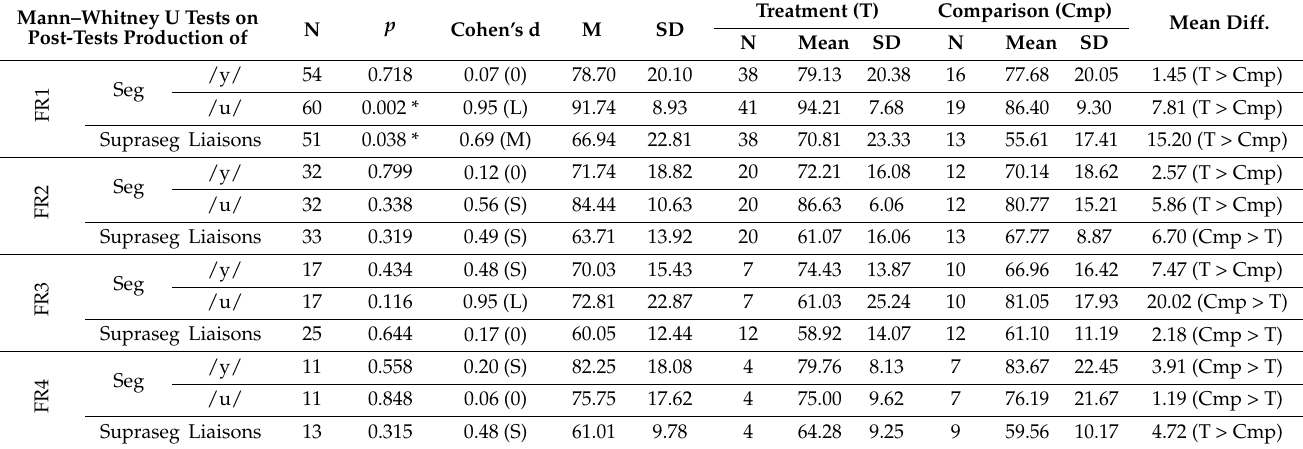
Table 5. Comparative results on the post-tests production of / y/-/u / and liaisons across semesters. Mann–Whitney U Tests on Post-Tests Production of